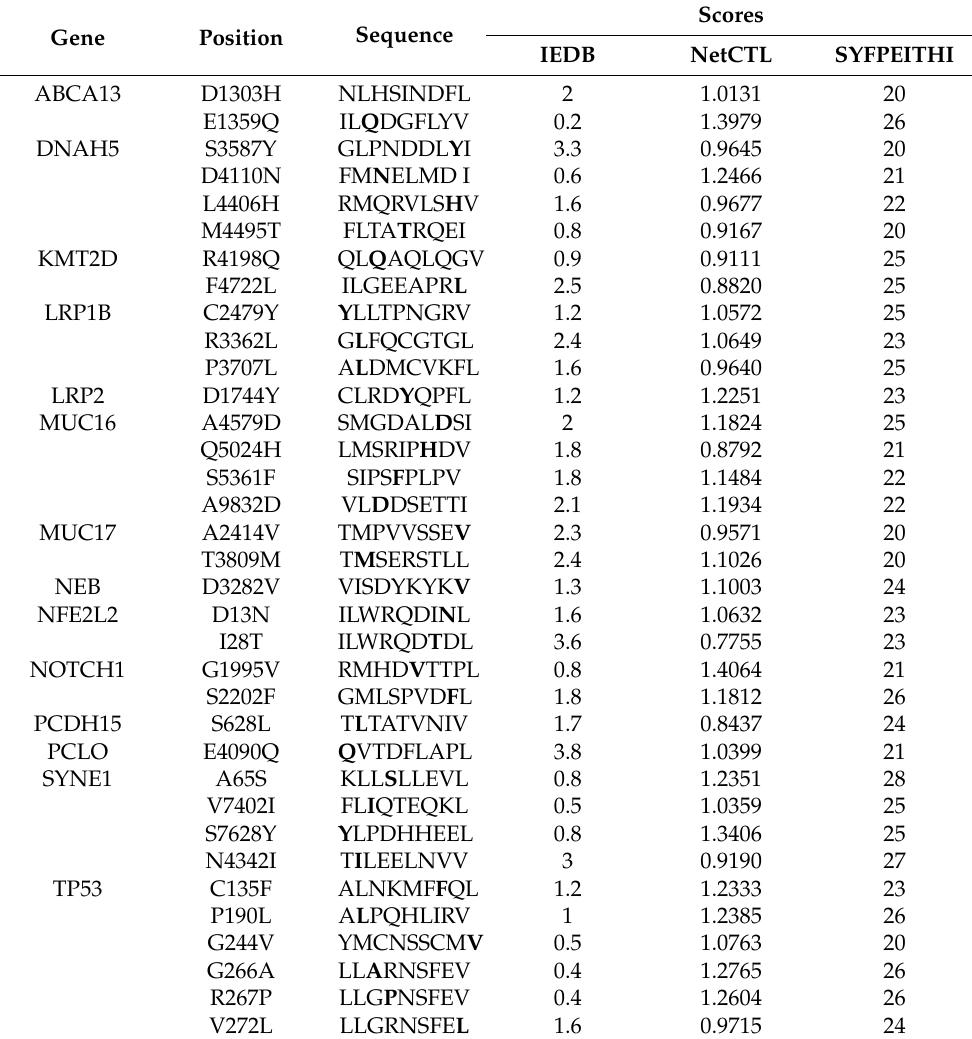
Table 1. Prediction scores of the mutant peptides derived from mutant antigens in ESCC.